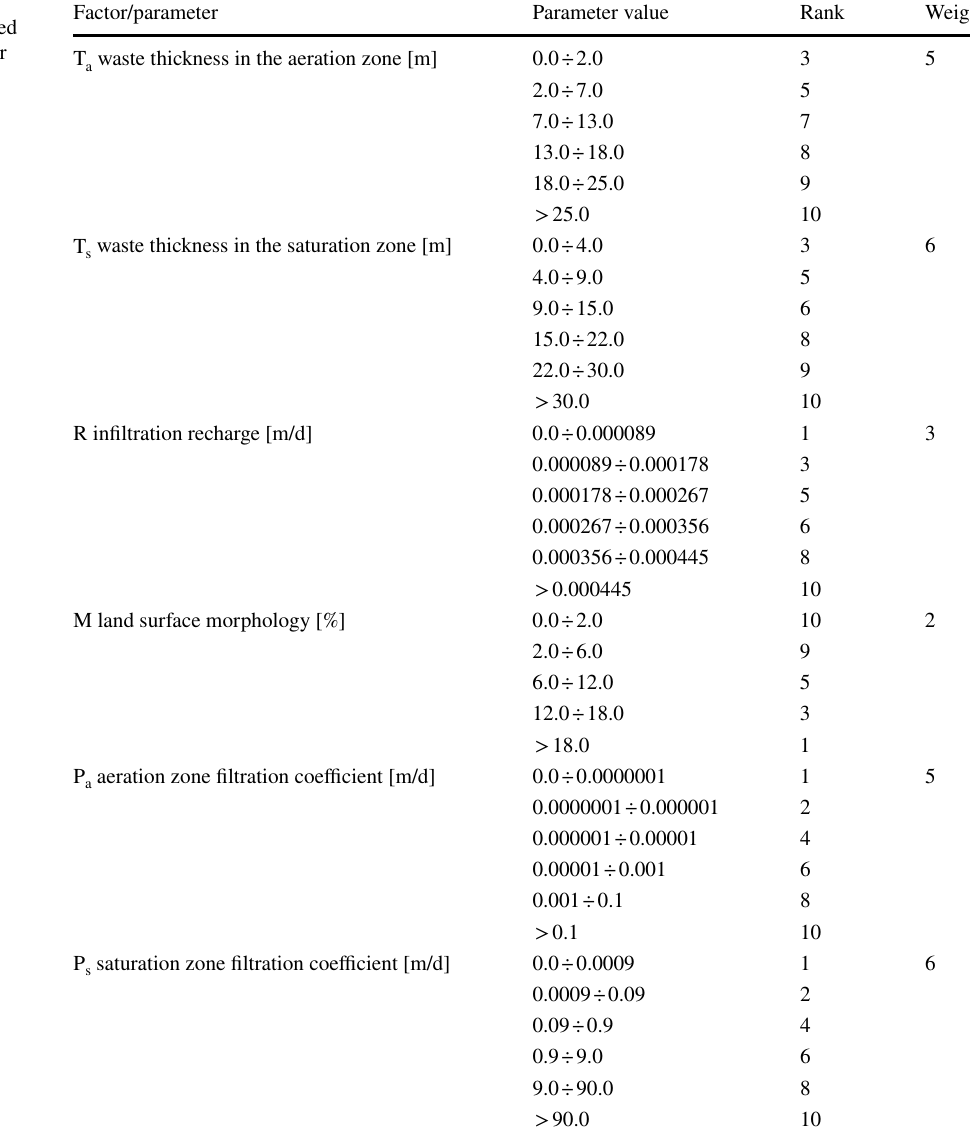
Table 1 Ranks and weights assigned to the factors selected for assessing the groundwater vulnerability to pollution